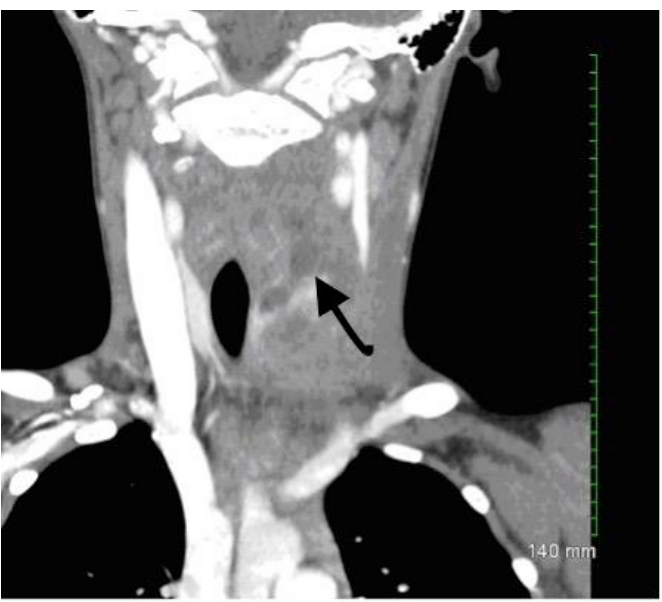
Image 1 . Coronal computed tomography of the neck demonstrating multiloculated heterogeneous fluid (arrow) in the left thyroid